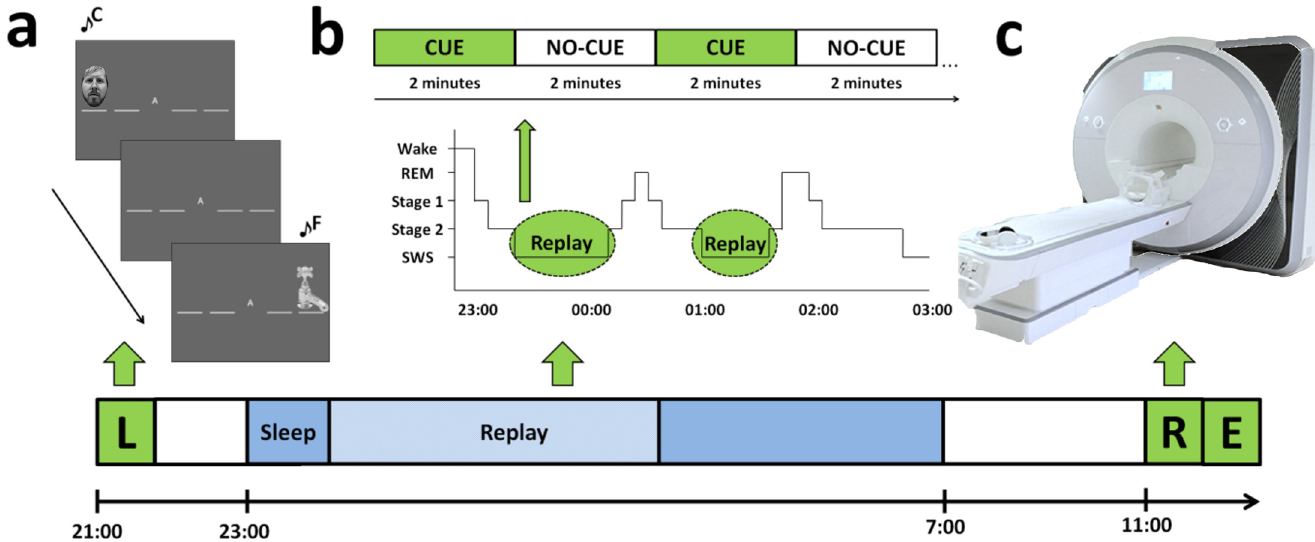
Fig 1. Schematic of experiment design. (a) Learning (L) of the SRTT task consisted of interleaved blocks of the cued and uncued sequence, and also random blocks. (b) The cued sequence is replayed during periods of SWS in groups of 12 sequences (CUE) and equivalent periods of silence (NO-CUE). (c) Retest (R) of the SRTT takes place the following morning in the MRI scanner, followed shortly afterwards by the explicit memory test outside of the scanner.